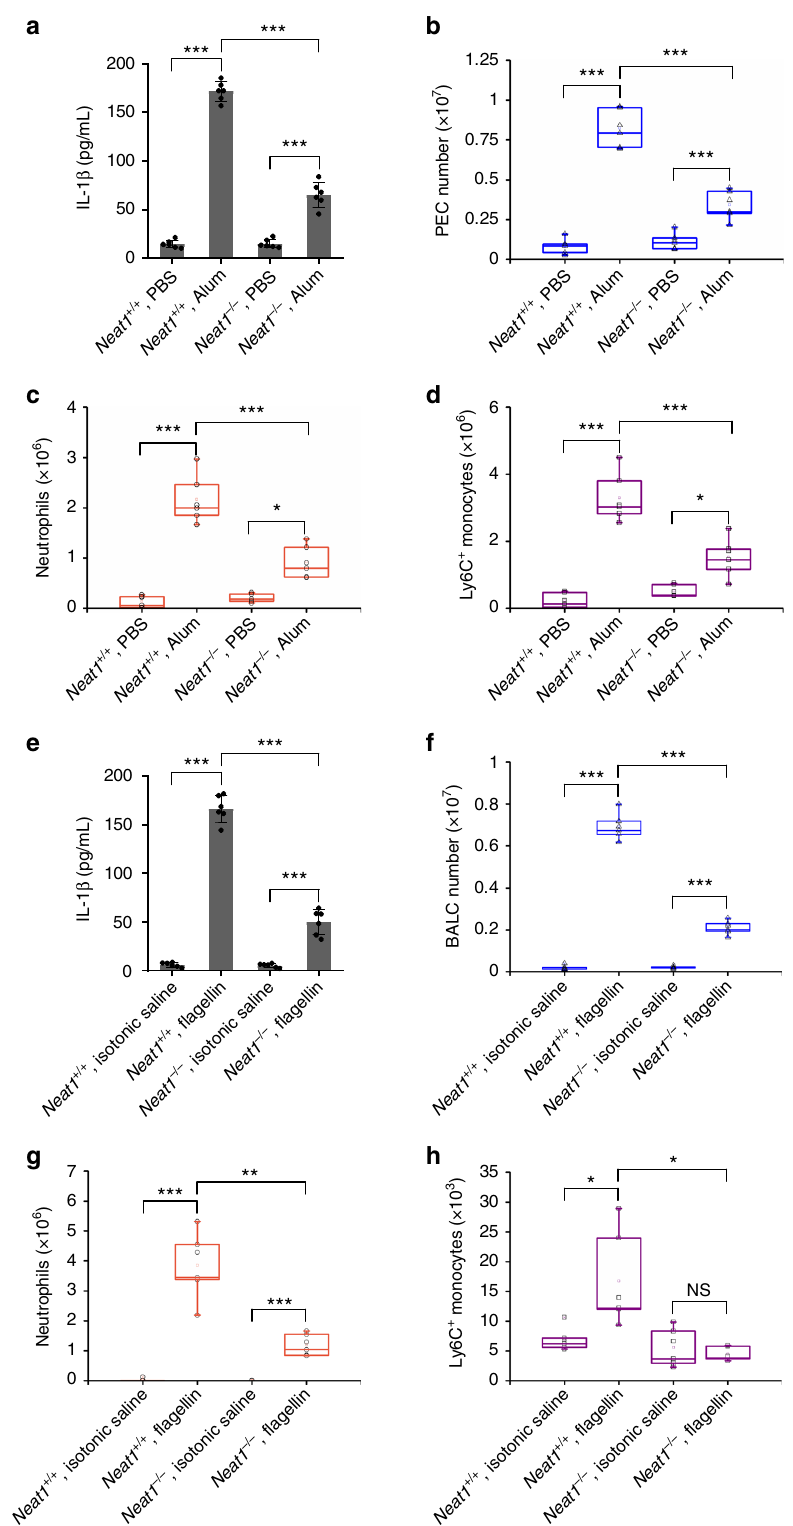
Fig. 10 Loss of Neat1 impairs alum-induced peritoneal in fl ammation and attenuates fl agellin-induced lung in fl ammation in vivo. a IL-1 β content in the lavage